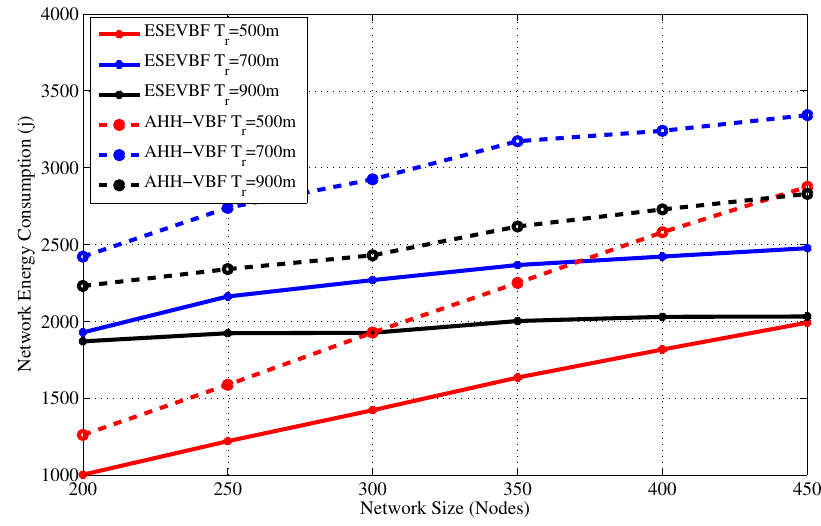
Figure 11. Overall network energy consumption versus the network size.